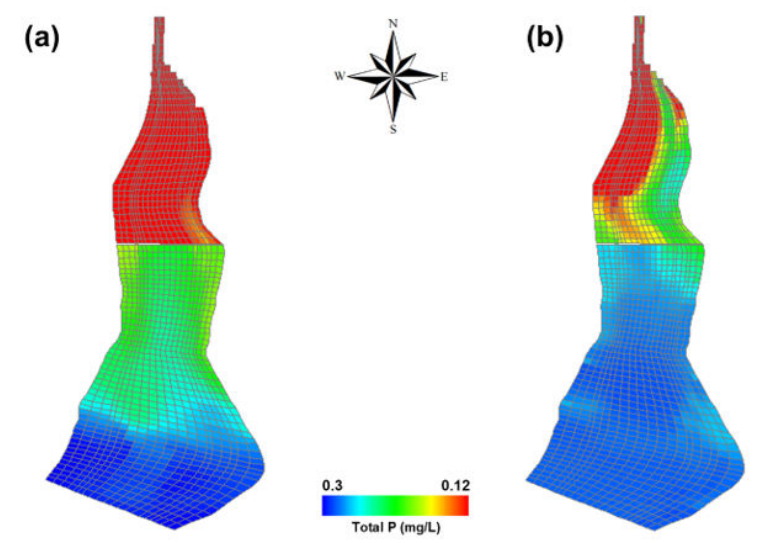
Figure 15. T-P concentration changes in the estuarine